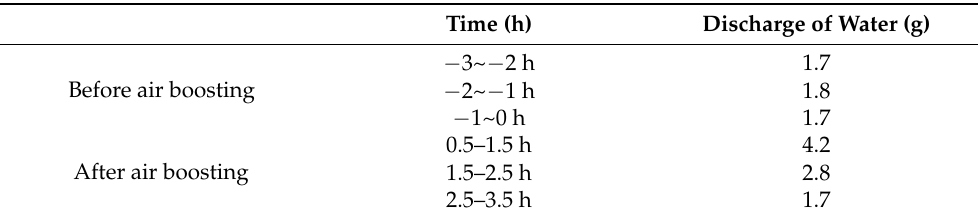
Time (h) Discharge of Water (g) − 3~ − 2 h 1.7 − 2~ − 1 h 0.5–1.5